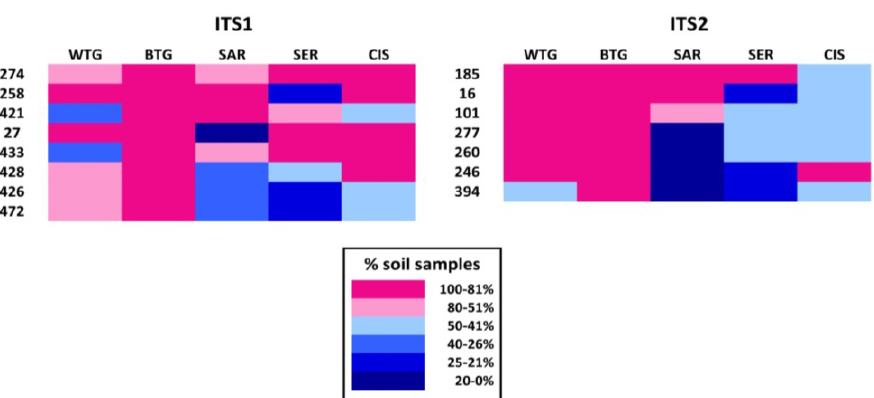
Figure 5. Heat maps of the OTUs occurring in all localities showing the frequency of each OTU in each sample group. Each column represents a different sample group; each row represents a different OTU; the color of the cells represents the frequency of that OTU within the sample group (percentage of the group samples the OTU was retrieved